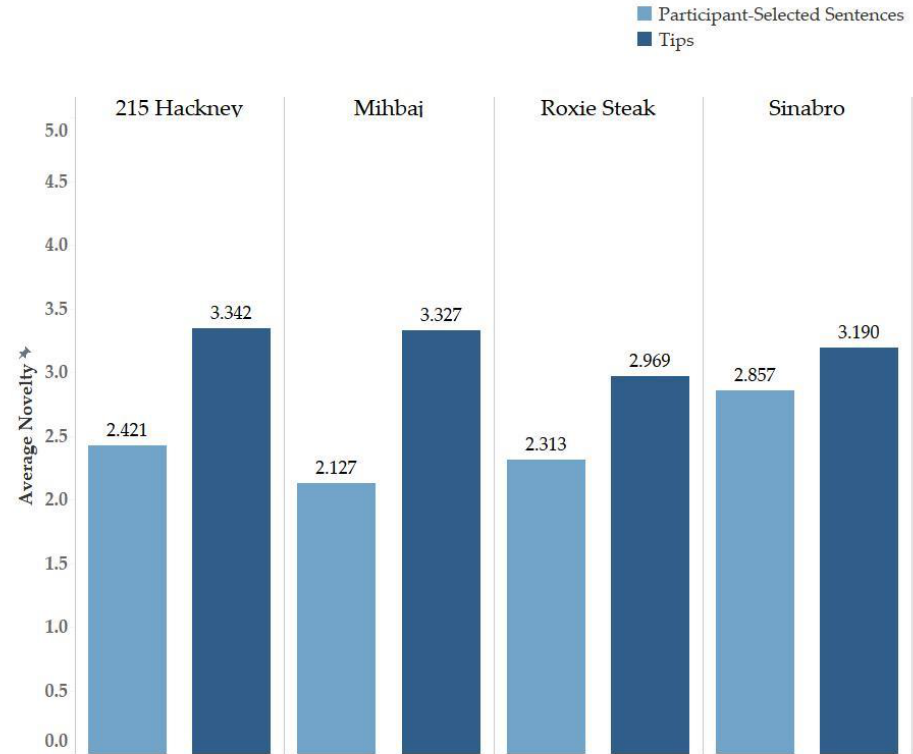
Figure 8. The novelty of tips and participant-selected sentences.